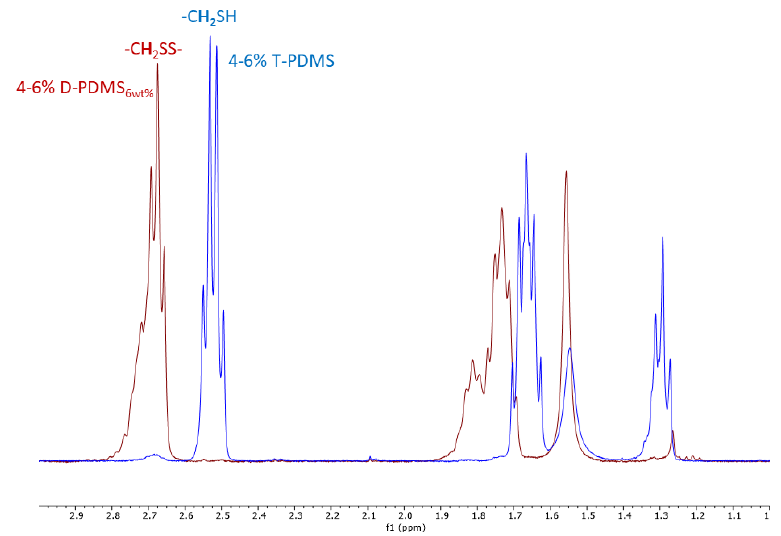
Figure 3. 1 H NMR spectra of 4–6% T-PDMS (blue) superimposed upon its oxidation product 4–6% D-PDMS 6wt% (red). The α methylene protons of the thiol (-C H 2 SH) and the disulfide (-C H 2 -SS-) are indicated.